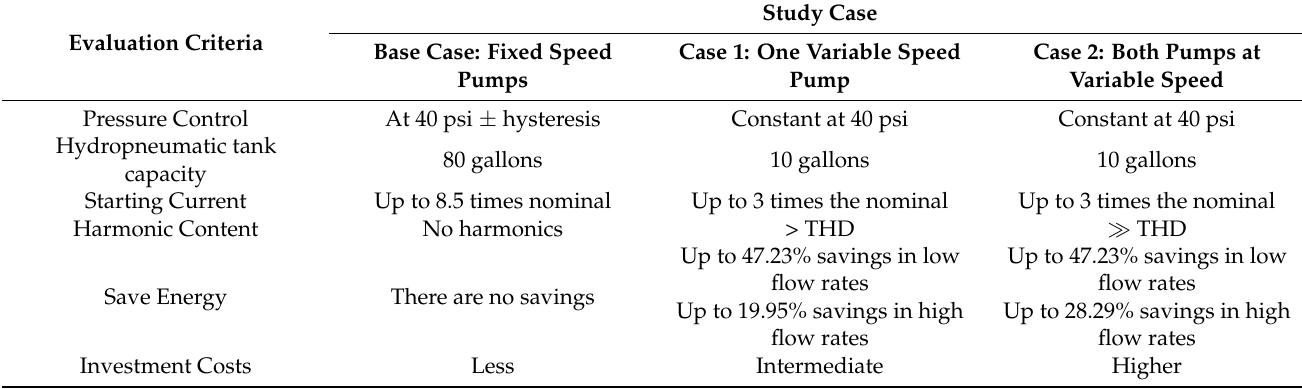
Table 3. Evaluation summary of the cases